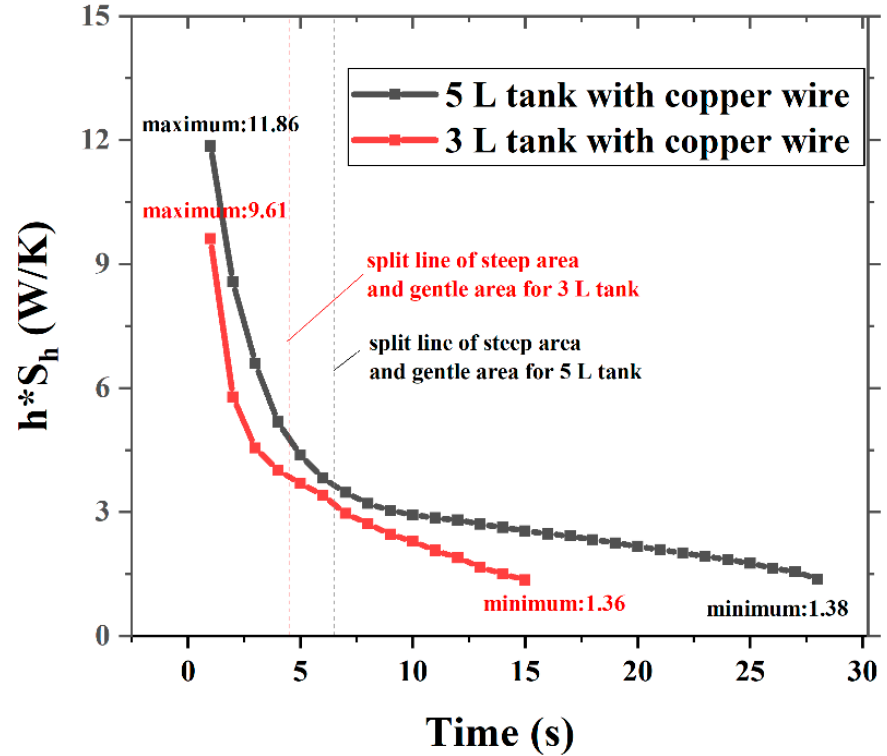
Figure 6. Actual value of overall heat transfer coefficient.